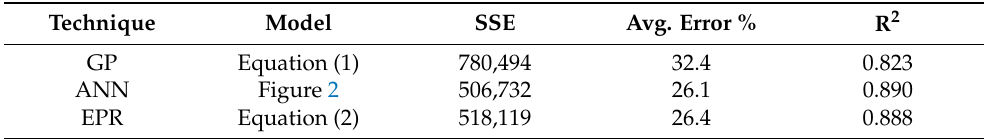
Table 4. Accuracies of developed